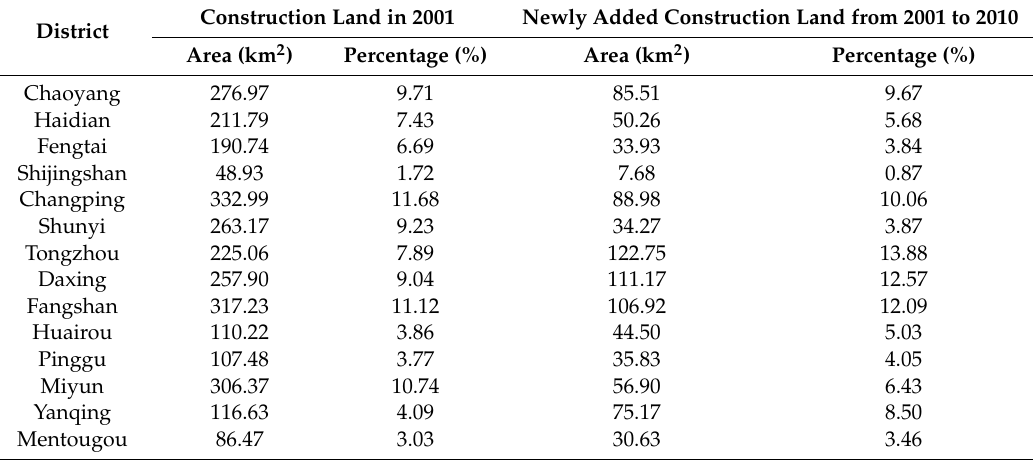
Table 3. Statistics of construction land in 2001 and newly added construction land from 2001 to 2010.